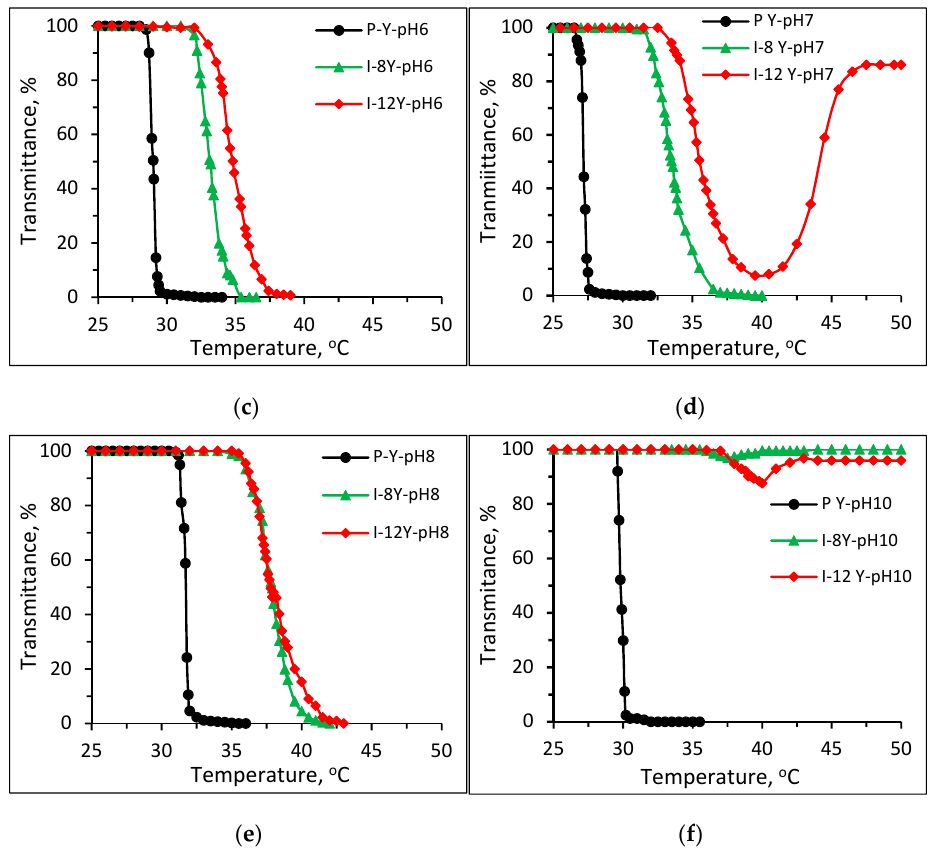
Figure 6. Plots of transmittance vs. temperature of 1 wt % aqueous solutions of Pnipam and P(nipam-co-IAM) synthesized with stereo-control in buffer solutions of ( a ) pH = 4, ( b ) pH = 5, ( c ) pH = 6, ( d ) pH = 7, ( e ) pH = 8 and ( f ) pH = 10.